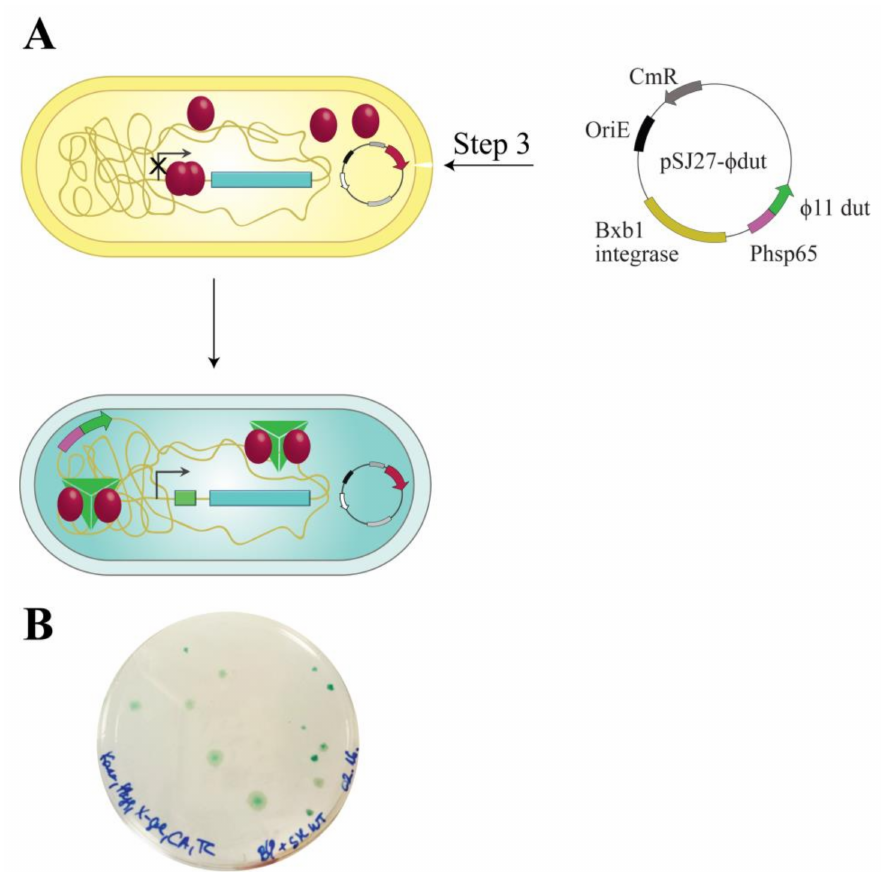
Figure 6. Workflow of the double switch system. ( A ) pSJ27- Φ 11dut vector was electroporated into the Stl switch system. The relatively high expression level of Φ 11 phage dUTPase enzyme is provided by a heat shock protein promoter (Phsp65). Φ 11 phage dUTPase is a known partner of Stl, able to promote Stl to release the regulated DNA [24,28]; ( B ) Validation of the detection of protein:protein interaction using the LacZ Str reporter system. Stl in complex with Φ 11 phage dUTPase releases DNA, therefore, blue colonies are formed. Note that the number of colonies represents the transformation